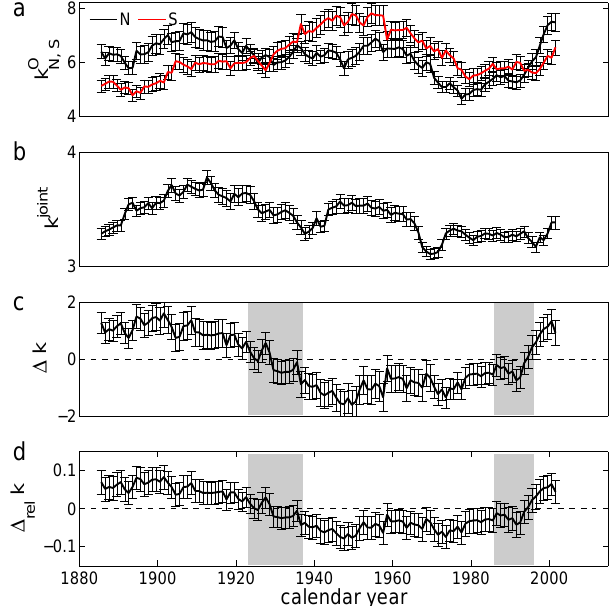
Figure 6. Conditional (a) and joint degree sequences (b) , and asso- ciated absolute (c) and relative excess degrees (d) obtained from the VGs of A N , S computed over the same sliding windows as in Fig. 2. Error bars display mean values and standard deviations within a given time window centered around the respective point in time. Gray areas mark those time intervals where the sign of the excess degree